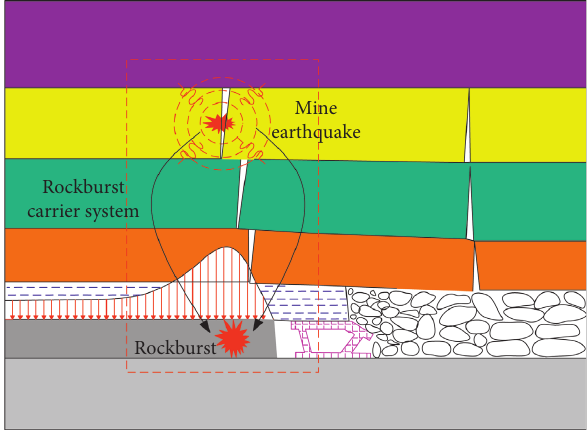
Figure 3: Shock-type rockburst carrier system